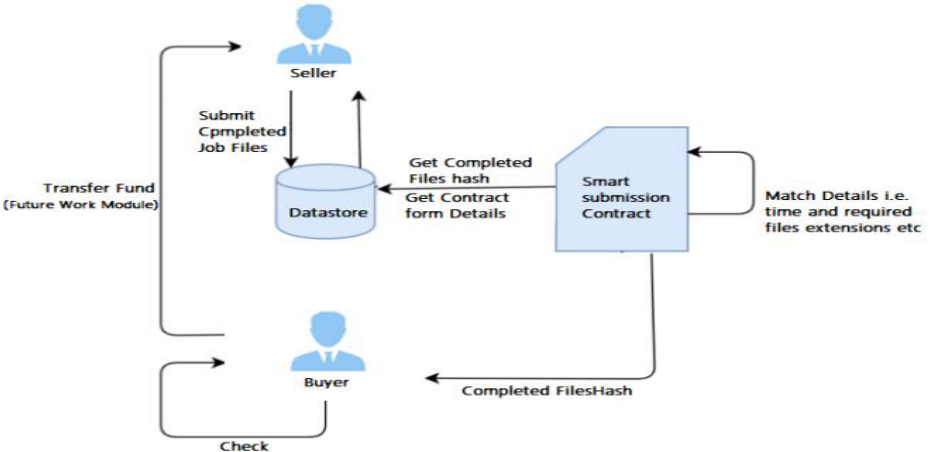
Figure 9. Prototype design of submission of a job after completion.